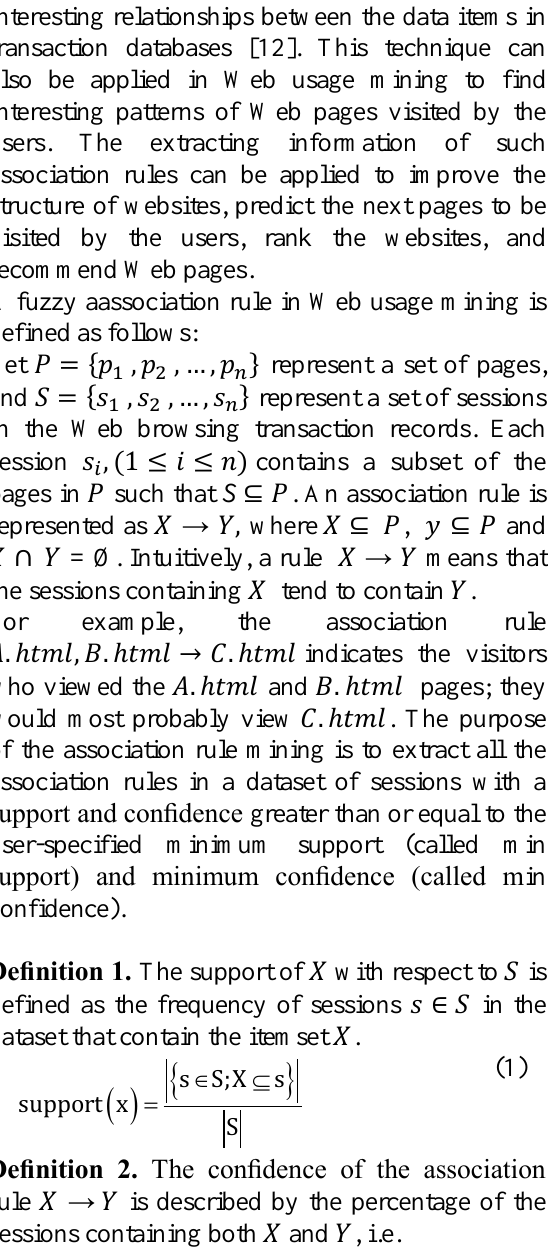
Figure 1. Interaction between the learning automata and the random